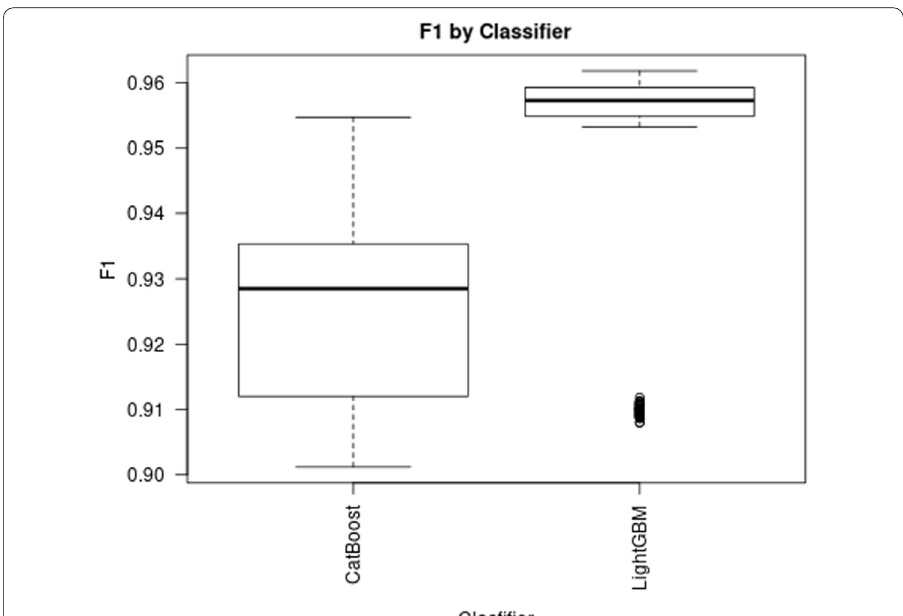
Fig. 7 Box plots of F1-score grouped by classifier; here datasets include destination port; Tukey’s HSD test indicates each factor (classifier) is in its own group